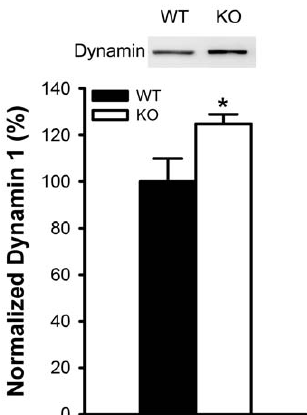
Figure 6. Dynamin 1 levels in the synaptosomal fraction of the hippocampi of Btbd9 mutant mice. Image is a representative Western blot analysis of dynamin in WT and Btbd9 mutant mice. Bar graph is quantitative analysis of the Western blot, showing a significant increase in dynamin 1 in the Btbd9 mutant mice. Bars represent means 6 SEM. *